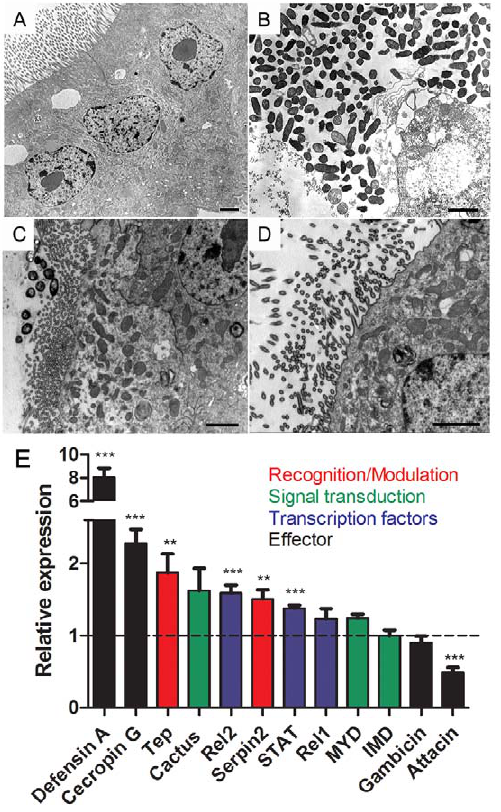
Figure 9. Bacterial infection in the presence of DPI causes cell damage and immune activation in mosquito midgut. Mosqui- toes were fed with BBSA with Enterobacter asburiae at a concentration of 4 6 10 9 CFU/mL with or without DPI (10 m M). 24 h later midguts were dissected and processed for transmission electron microscopy. (A) Mosquitoes infected with bacteria only. (B) Mosquitoes infected with bacteria + DPI (10 m M) to reduce ROS. (C) Mosquitoes fed with BBSA + DPI. (D) Mosquitoes fed with BBSA + DPI + antibiotics (penicillin/ streptomycin/tetracycline – 200 U/mL, 200 m g/mL, 100 m g/mL, respectively). All the scale bars represent 2 m m. (E) Gene expression analysis of whole body (minus head) mosquitoes 24 h after feeding with BBSA + bacteria + DPI. Dashed line indicates gene expression of mosquitoes fed with BBSA + bacteria (without DPI). Different classes of immune genes are indicated with